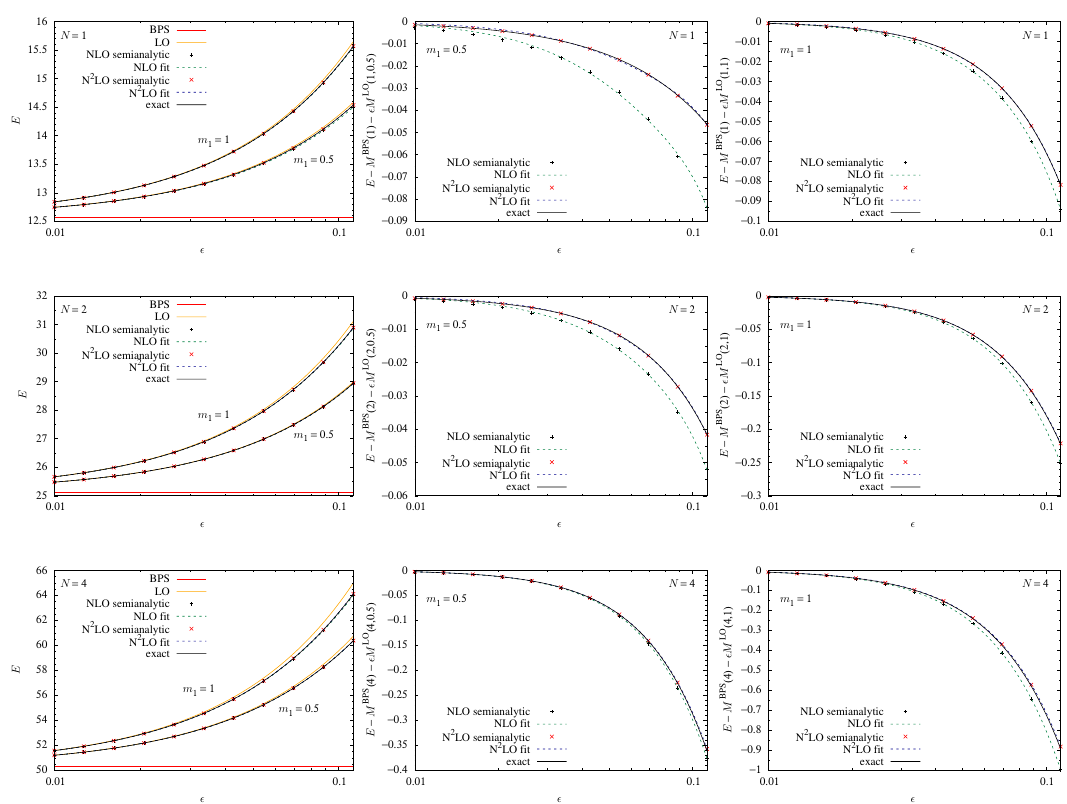
Figure 3. The energy (mass) of the baby Skyrmions in the perturbative (cid:15) -expansion scheme, as a function of (cid:15) (on a log-scale): the red line shows the BPS bound, the orange line is the leading-order (LO) correction, the black pluses are the next-to-leading order (NLO) corrections in (cid:15) calculated using the linear perturbation, the green dashed line is a fit to the NLO points, the red crosses are the next-to-next-to-leading order (N 2 LO) corrections in (cid:15) calculated using the same linear perturbation, the dark-blue dashed line is a fit to the N 2 LO points and the black line is the exact energy calculated using the full (nonlinear) equations of motion. The left columns show the total energy, E , the middle and right columns show the energy with the BPS and the LO correction subtracted off for m = 0 . 5 and m = 1 , respectively, to better see the differences between the 1 1 exact, NLO and N 2 LO